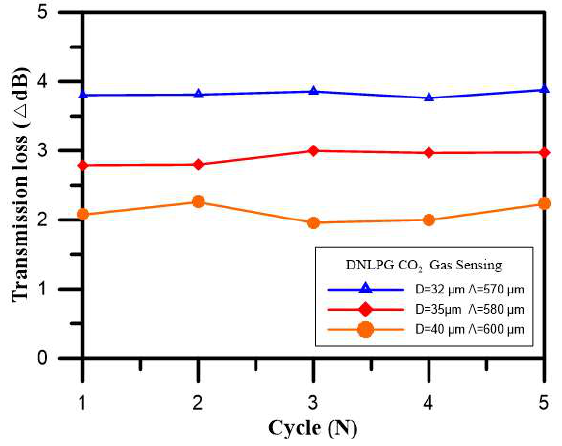
Figure 9 . Changes in transmission loss for the CO 2 gas sensors with different diameters . Figure 9. Changes in transmission loss for the CO